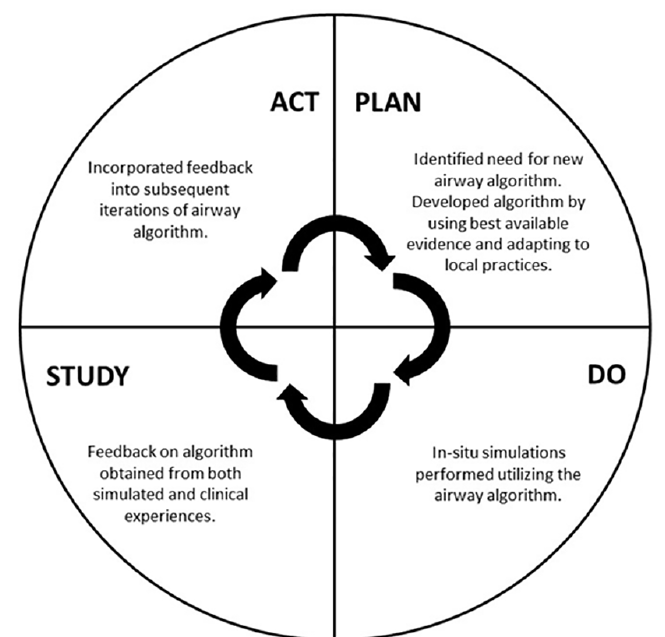
Figure 1. Plan Do Study Act cycle for refinement of the institutional airway algorithm for patients with suspected